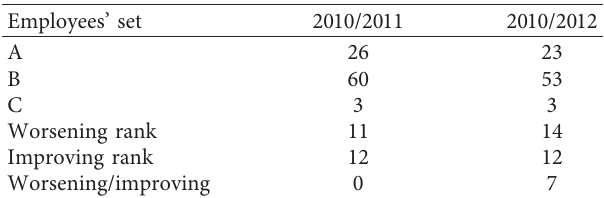
Table 4: Rank story of the employees in the real case. Number of employees which changes or does not change their rank during the periods 2010/2011 and 2010/2012.